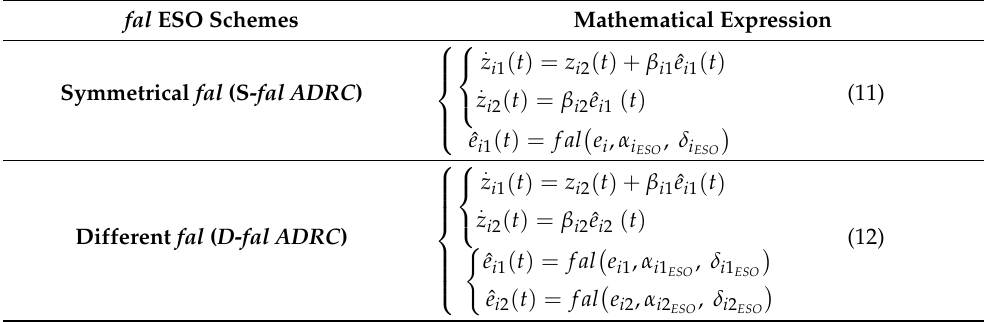
Table 3. The f al function ESO mathematical expression. 𝒇𝒂𝒍 ESO Schemes fal ESO Schemes Mathematical Expression